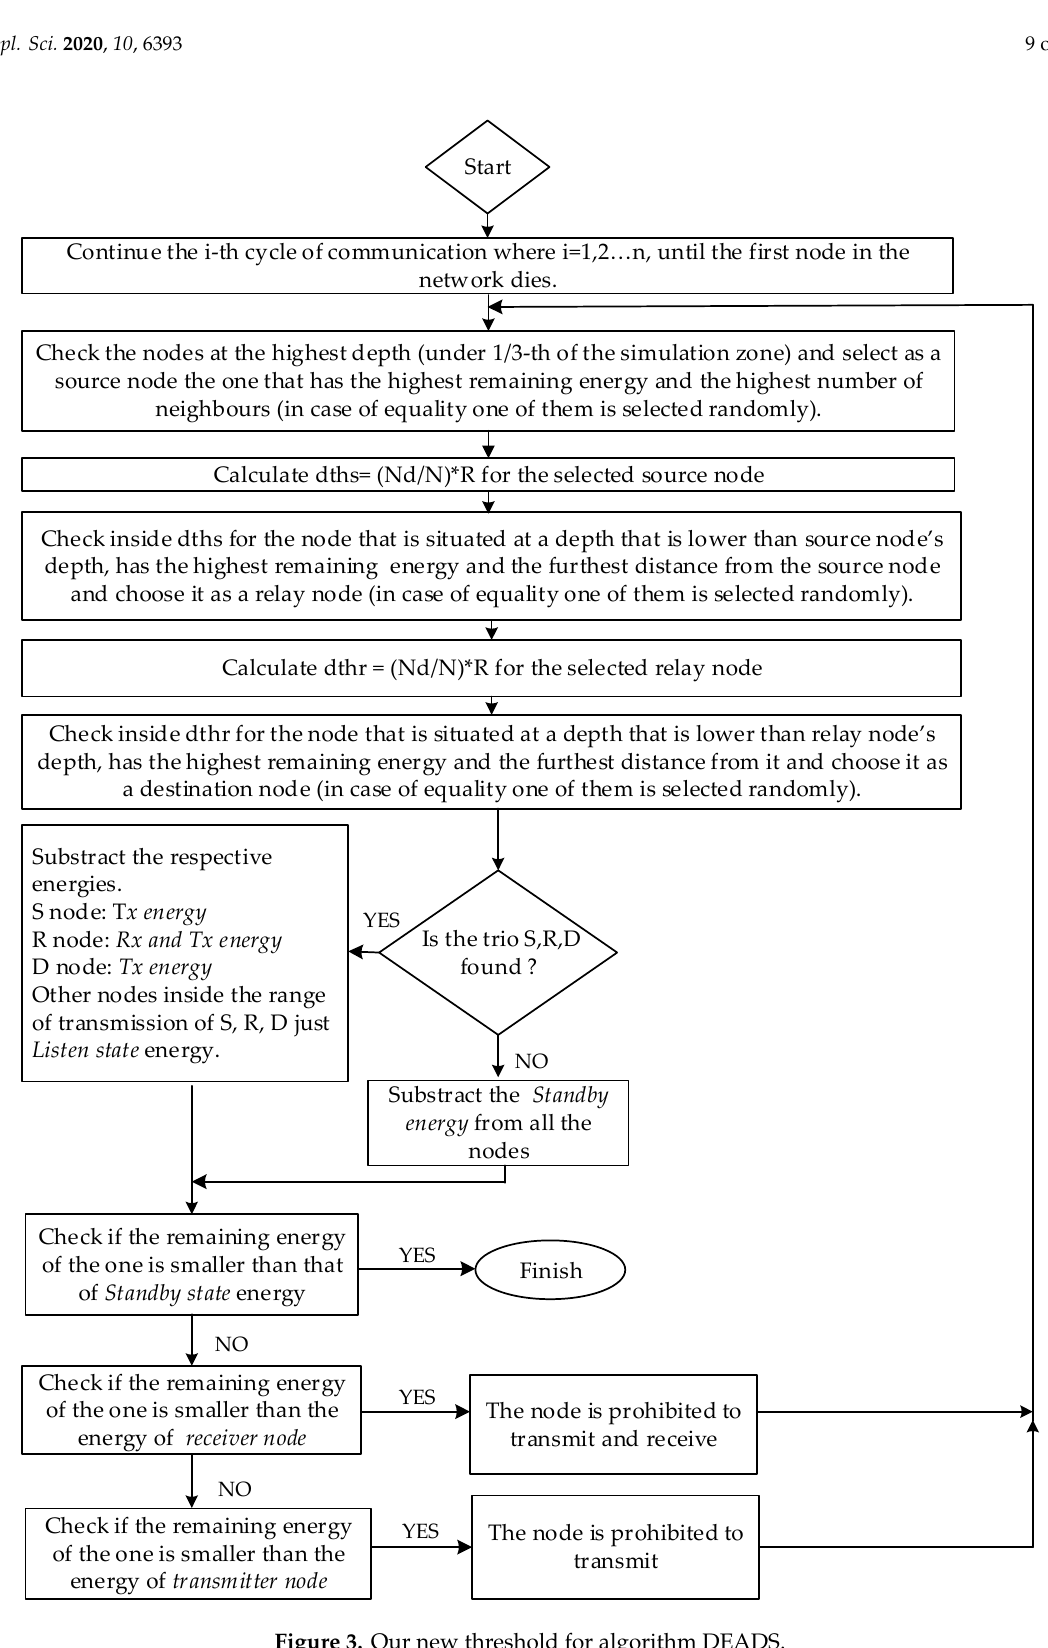
Figure 3. Our new threshold for algorithm